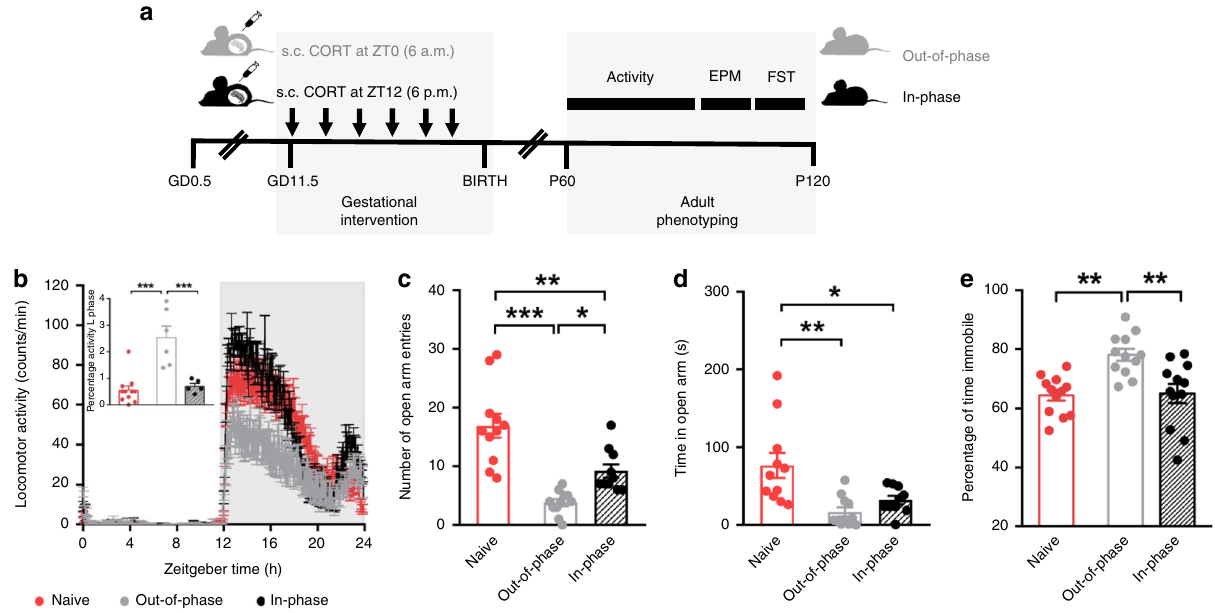
Fig. 1 The time of maternal exposure to GCs predicts the offspring ’ s behavior. a Scheme of the gestational intervention by subcutaneous (s.c.) injections of corticosterone (CORT) either at Zeitgeber time 0 (ZT0, 6 a.m) or at ZT12 (6 p.m). Long-term effects on the offspring ’ s circadian stress system were assessed at behavioral level from postnatal day 60 (P60) to P120. To con fi rm the effect of the preterm manipulation itself (including handling and CORT administration from gestational day (GD) 11.5 until birth), we also included a naive group of adult mice (always in red) whose mothers were left undisturbed during their whole pregnancy. b Circadian pattern of locomotor activity in 12-h light:12-h dark cycle conditions and percentage of activity during the light (L) phase (inset). The running-wheel counts/min of 10 days were averaged for each individual animal (naive n = 11, out-of-phase n = 6, in- phase n = 5). c Number of open arm entries in the elevated plus maze (EPM) (naive n = 11, out-of-phase n = 11, in-phase n = 10). d Time spent in the open arm of the EPM (naive n = 11, out-of-phase n = 11, in-phase n = 10). e Percentage of time spent immobile in the forced swim test (FST) ( n = 12 for all groups). All behavioral tests were performed once. All data are expressed as means ± SEM. Data in b (inset), c – e were analyzed by one-way ANOVA; b F (2,19) = 17.60, p < 0.0001; c F (2,29) = 22.33, p < 0.0001; d F (2,29) = 8.79, p = 0.001; e F (2,33) = 9.78, p = 0.0005; followed by Sidak ’ s